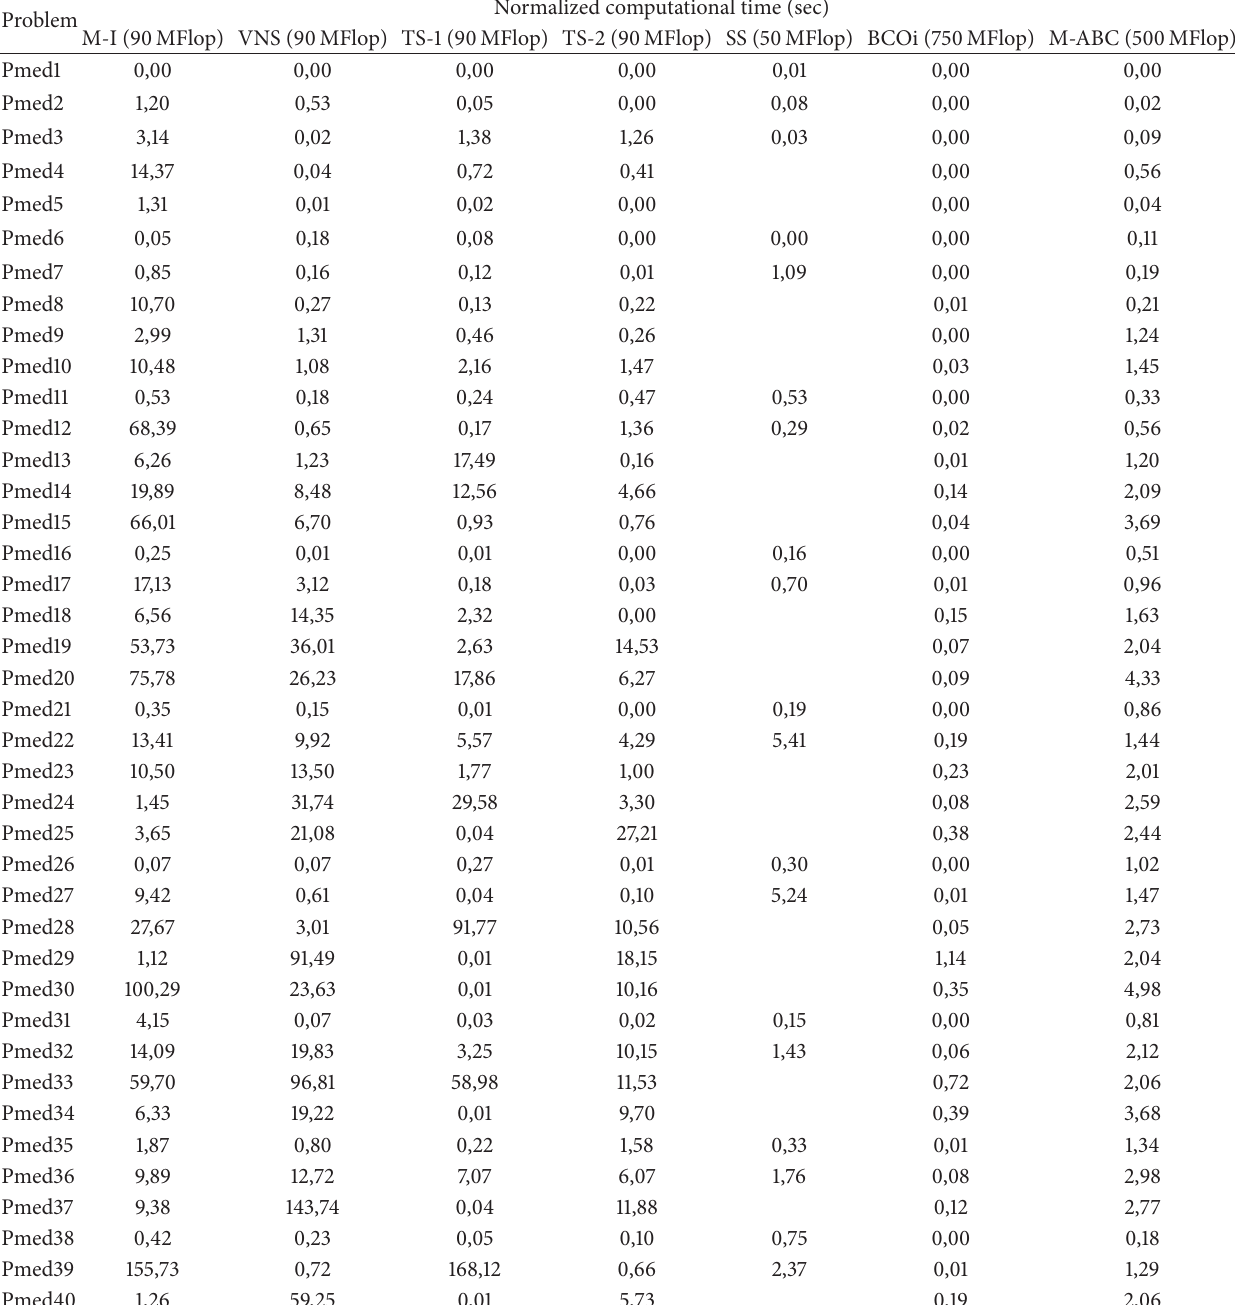
Table 2: CPU time